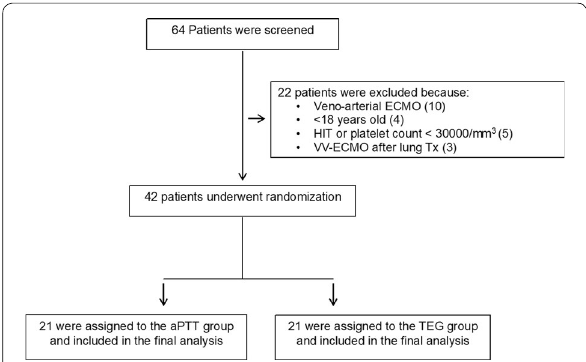
Fig. 2 Flow diagram. We assessed 64 patients for eligibility. Of these, patients 22 were excluded. We enrolled and randomly assigned the remaining 42 to the aPTT or TEG arm. Thirty-one patients were enrolled in the Fondazione Ca’ Granda (Milan, Italy) center and 11 patients in the ISMETT (Palermo, Italy)